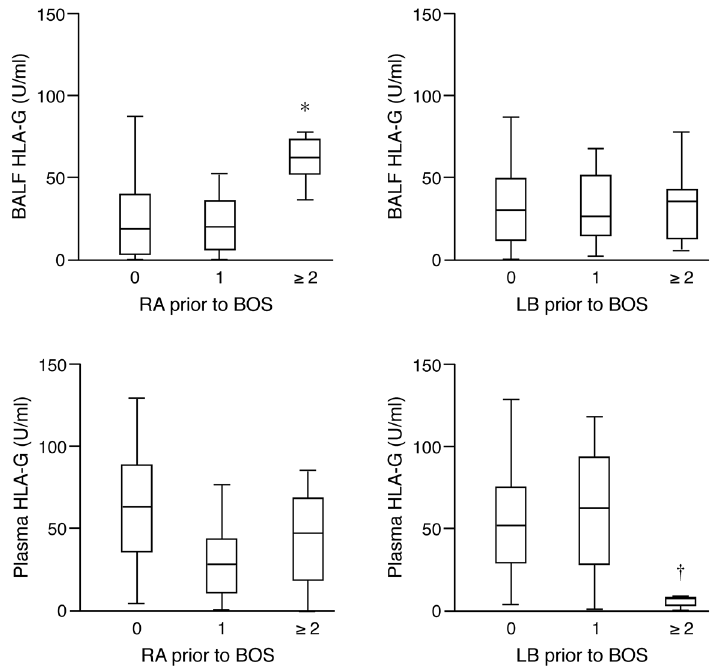
Figure 3. Concentrations of sHLA-G, in maximum U/ml prior to onset of BOS, in bronchoalveolar lavage fluid (BALF) (upper panels) and plasma (lower panels) in 38 subjects based categorized by grade A rejection status (RA, left panels) or by grade of lymphocytic bronchiolitis (LB, right panels). *, P=0.006 by Kruskal-Wallis test, { , P=0.044 by Kruskal-Wallis test.